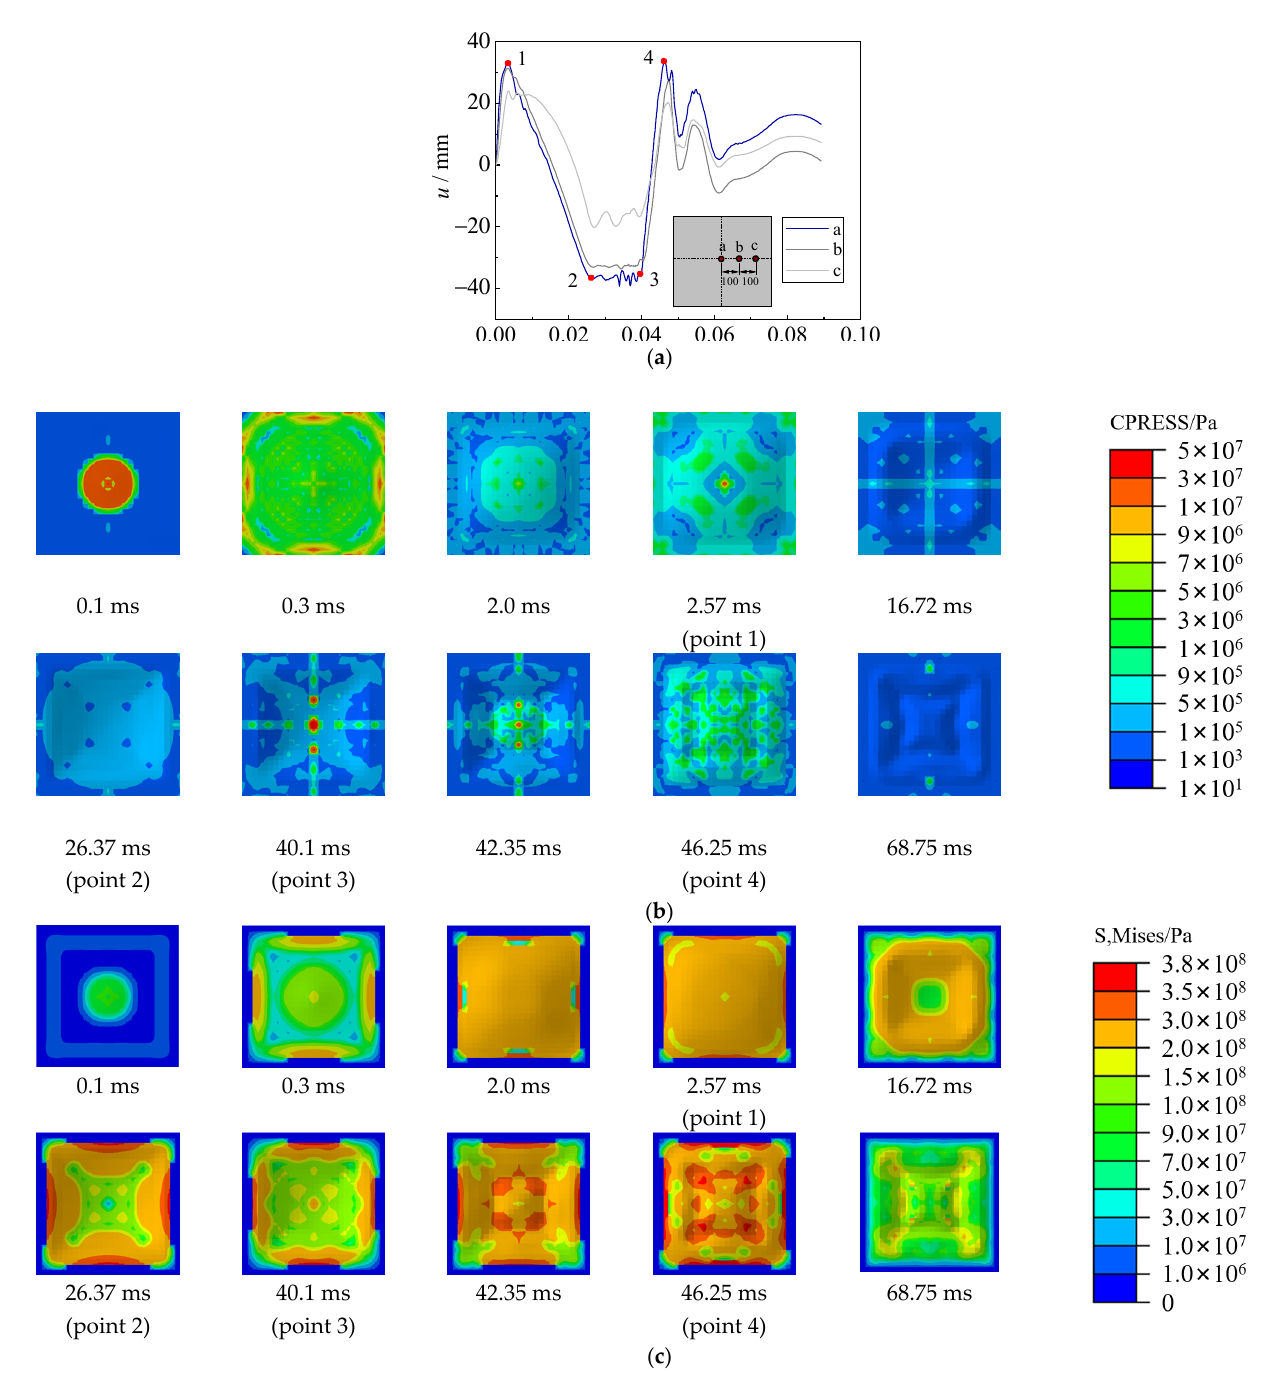
Figure 16. Displacement and stress development of specimens with 5 g TNT. ( a ) Displacement time–history curve. ( b ) Contact stress (CPRESS). ( c ) von Mises stress of steel sheet (S,Mises).